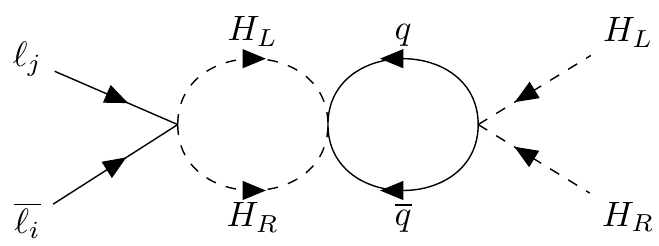
Figure 5 . Radiative corrections to y i 1 from charged leptons and quarks in the EFT. Loop momenta near the quark EFT cutoff scale, Λ c , lead to